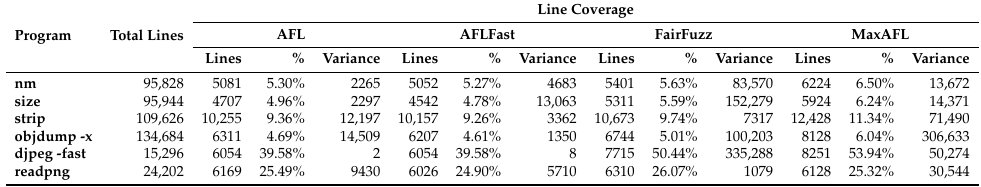
Figure 7. Each solid line is average line coverage of each fuzzer. The background colors describe the range between the maximum and minimum line coverage. Table 3. Line coverage after 12M executions. We described the line coverage of each fuzzer in absolute number of lines and percentage of a total lines. We also provide variance of final line coverage in eight independent